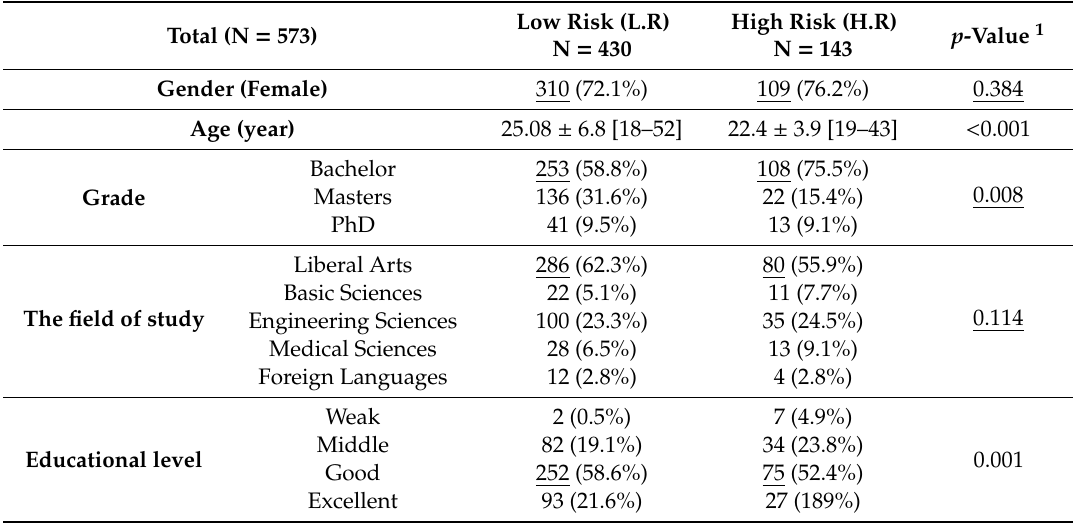
Table 1. Demographic characteristics in MEAN ± SD [min-max] for interval, and frequency (percentage) for categorical